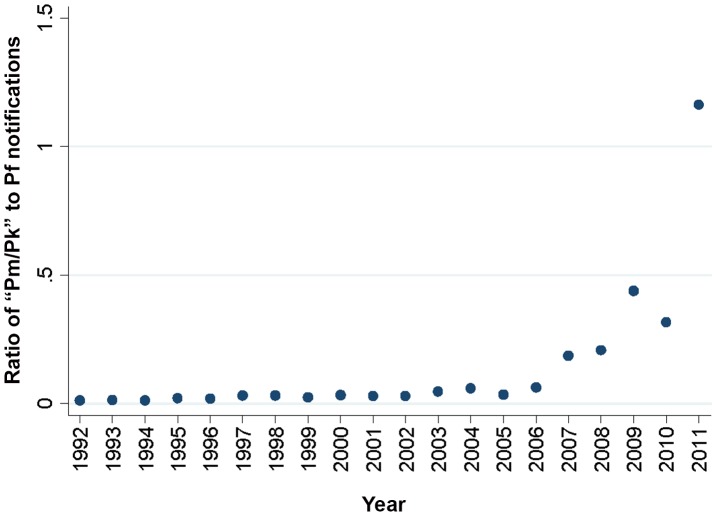
Ratio of P. malariae/P. knowlesi to P. falciparum notifications, 1992–2011.Pm/Pk = P. malariae/P. knowlesi, Pf = P. falciparum.